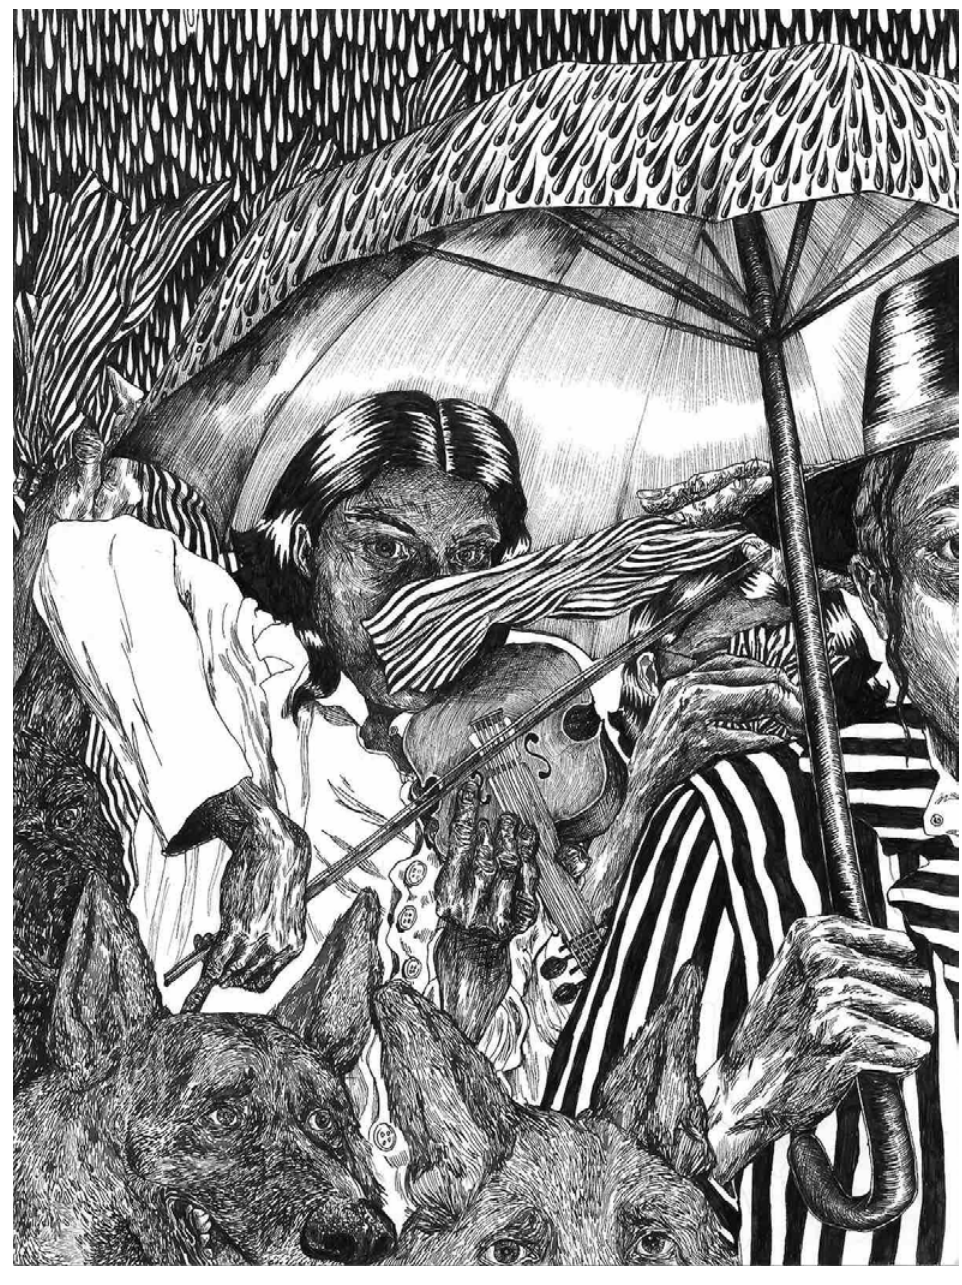
Rosabel Rosalind Kurth-Sofer, Exodus V , 2018. Pen and ink on paper. 9x11